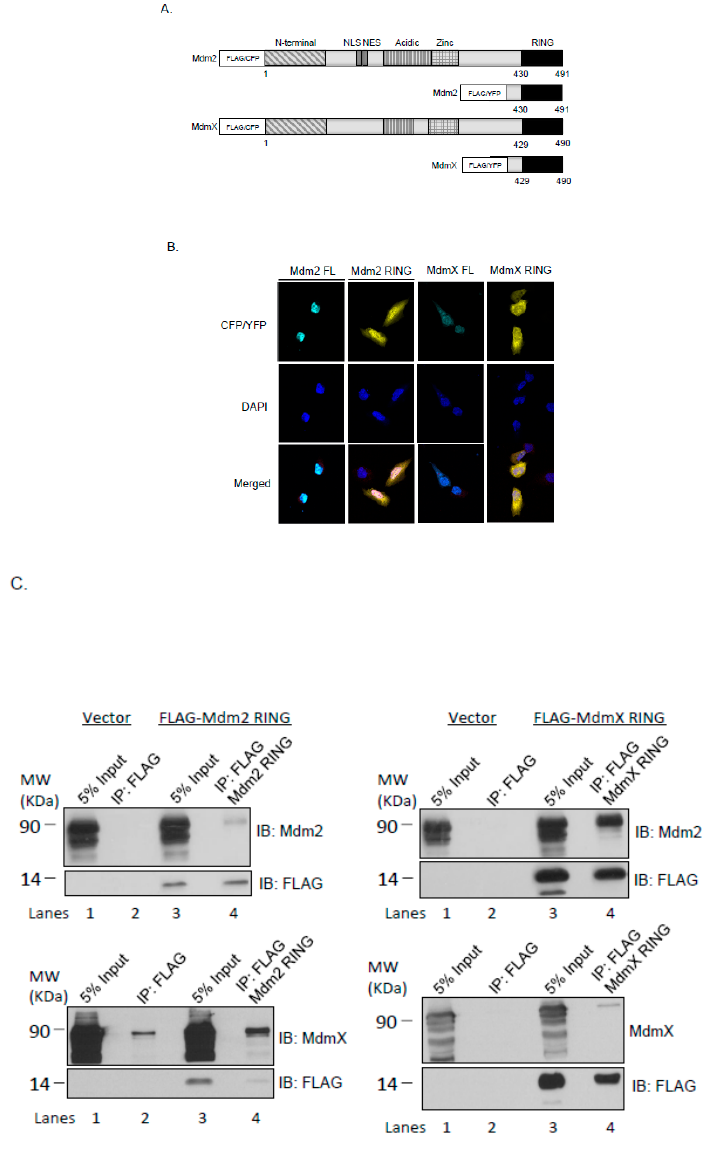
Figure 1. Cellular localization and interaction of the ectopically expressed Mdm2 RING and MdmX RING domains. ( A ) Domain arrangement of Mdm2 and MdmX proteins and constructs used in this study. Both Mdm2 and MdmX possess N-terminal p53-binding domains (N-terminal), central acidic domains (Acidic), zinc finger domains (zinc), and C-terminal RING domains (RING). Mdm2 alone contains a nuclear localization signal (NLS) and a nuclear export sequence. Numbers indicate amino acid residue positions. Wild type full-length Mdm2 and MdmX were expressed as FLAG- or CFP-fusion proteins; Mdm2 and MdmX RING were expressed as FLAG- or YFP-fusion proteins. ( B ) U2OS cells were transfected with CFP-Mdm2, CFP-MdmX, YFP-Mdm2 RING, and YFP-MdmX RING. Cells were fixed at 24 h post-transfection. Nuclei were stained with DAPI. Results indicate nuclear localization of the full-length Mdm2 and overlapping nuclear and cytoplasmic localization of the full-length MdmX, Mdm2 RING, and MdmX RING domains. Scale bars represent 5 µ M. ( C ) Co-immunoprecipitation of Mdm2 and MdmX with Mdm2 RING and MdmX RING. U2OS cells were co-transfected with an empty FLAG vector, Mdm2 FL, MdmX FL, FLAG-Mdm2 RING, or FLAG-MdmX RING as indicated to examine the interaction between Mdm RINGs and the full-length Mdm proteins. Co-immunoprecipitation was carried out 24 h post-transfection using a polyclonal anti-FLAG antibody. Immunoblotting was carried out with Mdm2, MdmX and FLAG specific